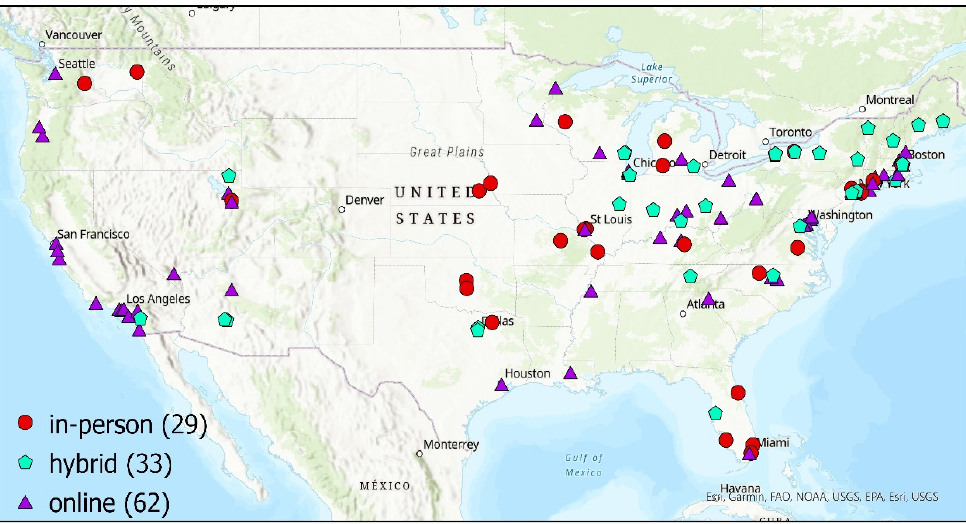
Figure 1. The distribution of universities. Note: this figure shows the distribution of 128 universities by teaching modes of in-person, hybrid, and online from March to October 2020. by teaching modes of in-person, hybrid, and online from March to October